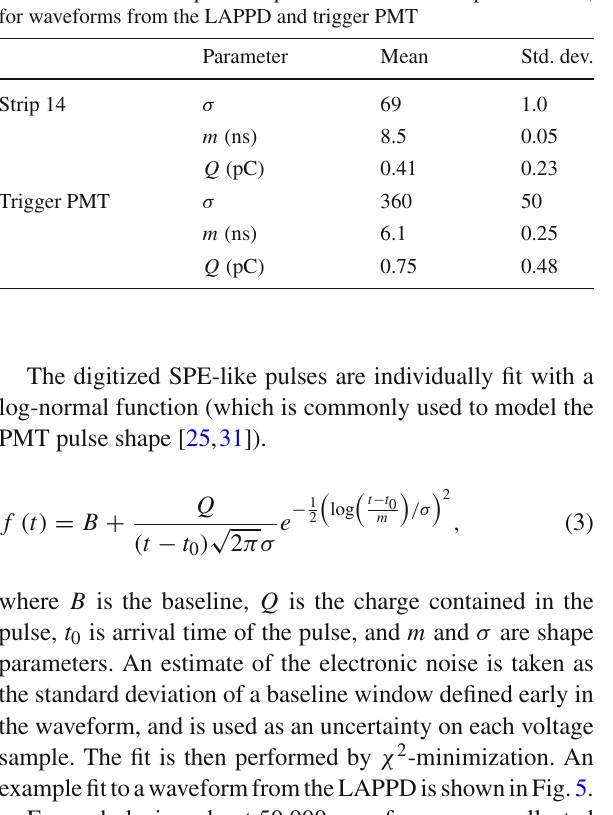
Fig. 6 Efficiency-calibrated trigger PMT charge distribution, in both data and MC, for a water target. The χ 2 /ndf comparing the data and MC is